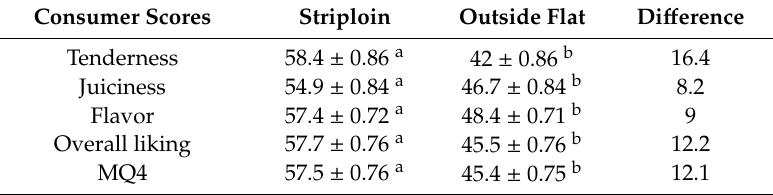
Table 3. Estimated marginal means ( ± 95% confidence interval) and the di ff erence between striploins ( M. longissimus lumborum ) and outside flats ( M. biceps femoris ) scores for tenderness, juiciness, flavor, overall liking, and eating quality (MQ4) 1,2